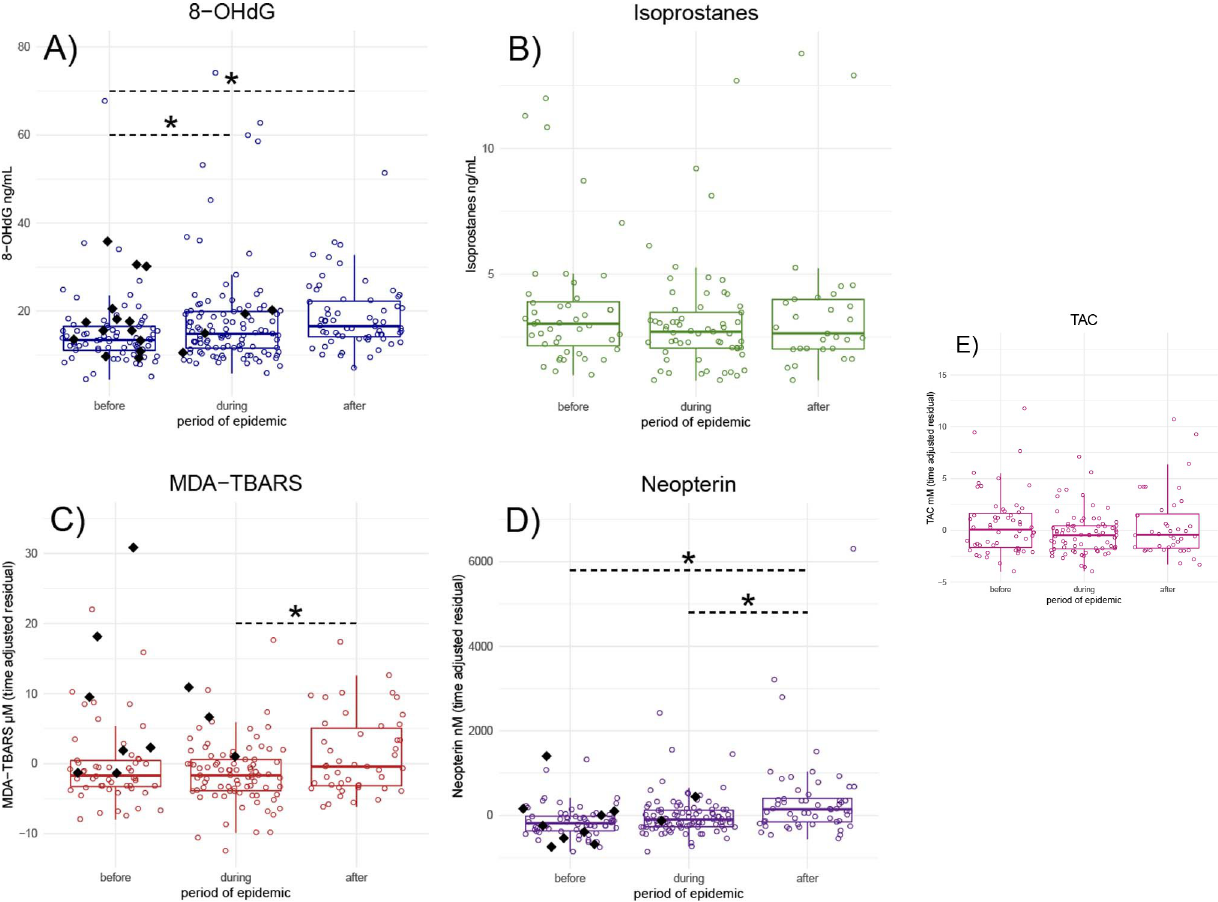
Fig 2. Variation in concentrations of A) 8-OHdG, B) F-Isoprostanes, C) MDA-TBARS, D) neopterin, and E) Total antioxidant capacity before, during, and after a severe respiratory epidemic. Points are individual sample-day concentrations. Black diamonds are sample-days from any of the 5 individuals that died during the epidemic. Boxes represent median and interquartile ranges of concentrations. Horizontal dashed lines indicate significant contrasts in biomarker concentrations between periods determined by generalized linear mixed effects models. For N individuals and samples per biomarker see